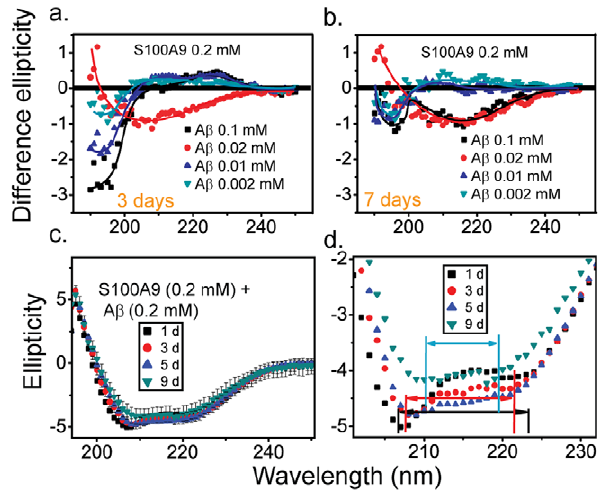
Figure 4. Measurements of NHSY5Y cell line viability by WST1 assay in the presence of 0.02 mM S100A9 and various S100A9/ A b 1–40 mixtures. The S100A9 concentration remained 0.02 mM. The concentration of A b 1–40 addition varied from 0.02 mM to 0.4 mM. In control experiments, the cells were incubated in DMEM cell culture buffer alone and the cell viability was equal to 100%.